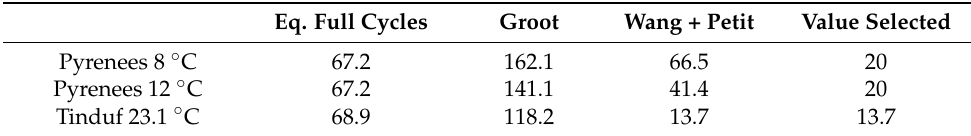
Table 5. Results. Battery lifetime estimation (years) for Li-ion